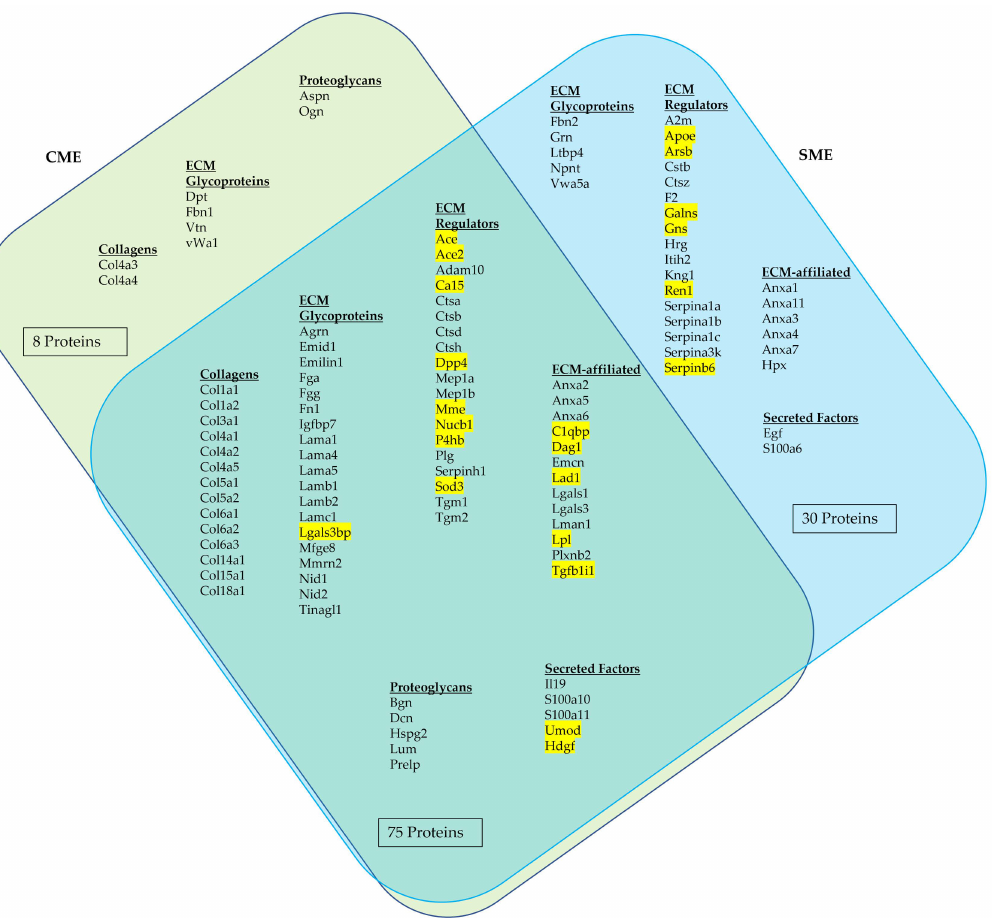
Figure 2. Identified matrisome proteins with unique peptides obtained from the samples processed via CME and SME methods. Venn diagram illustrates the common and unique matrisome proteins identified using each method. The proteins highlighted proteins in yellow have not been previously listed in the